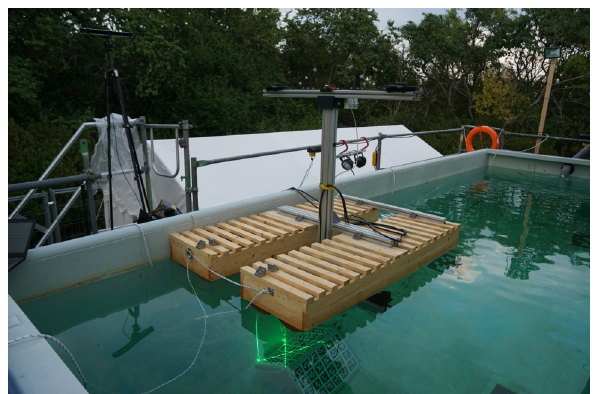
Figure 1. Underwater scanning system mounted to a raft for evaluation in a water